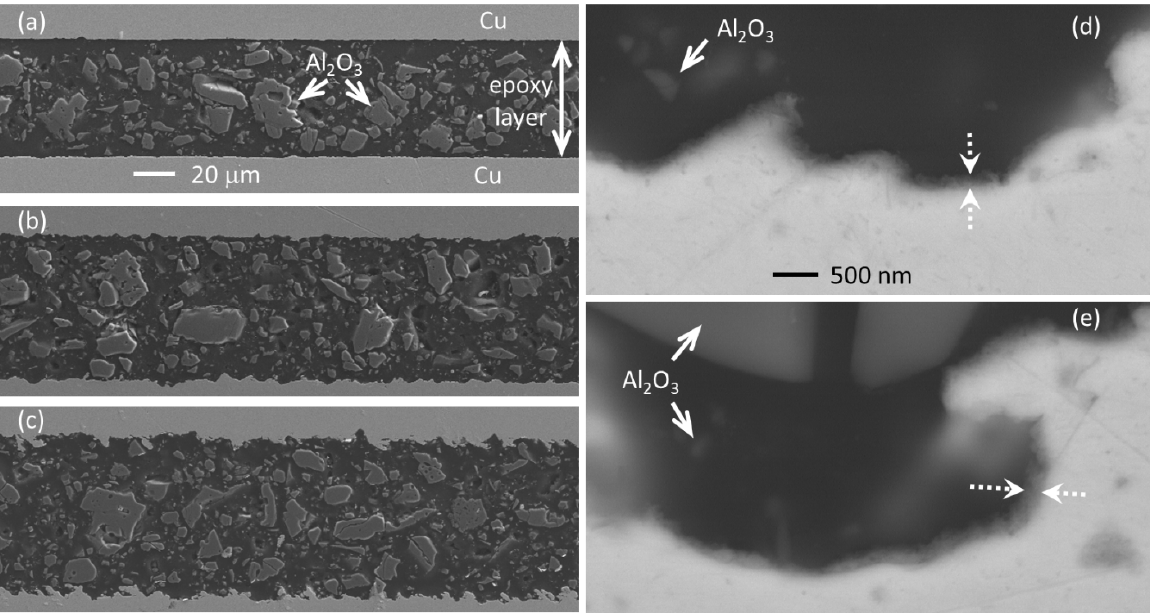
Figure 6. Left column : SEM images (secondary electrons) of the cross-sections of the three Cu/epoxy/Cu joints that were cut and polished after thermal measurements: ( a ) non-irradiated copper surfaces; ( b,c ) laser processed surfaces using LSM with F p = 1.43 and 2.35 J/cm 2 , respectively (same magnification in a , b , c ). Right column : ( d,e ) SEM images (backscattered electrons) of the interface between Cu and epoxy for the samples shown in ( b , c ), respectively. The same magnification was used in ( d , e ). Al 2 O 3 particles embedded in the epoxy layer are clearly seen in all images.